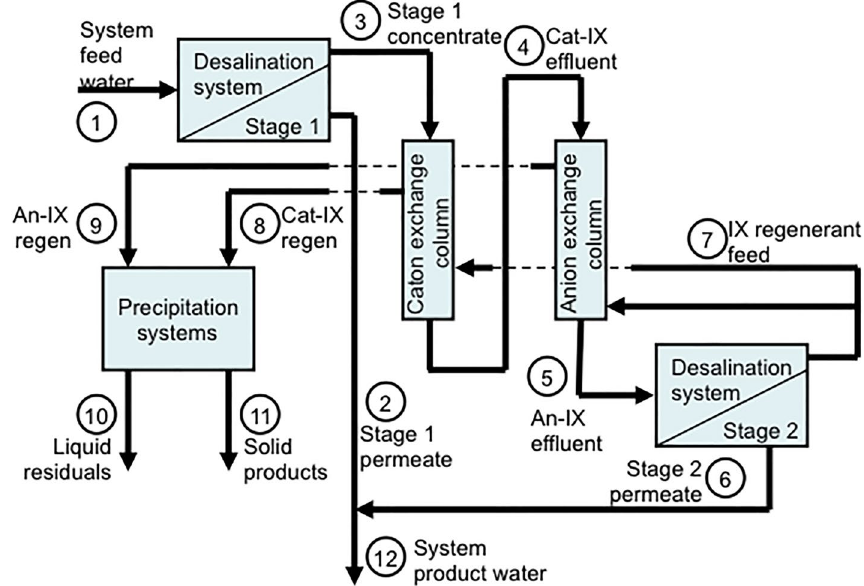
Fig. 9 Layout of the hybrid IX/ RO process for